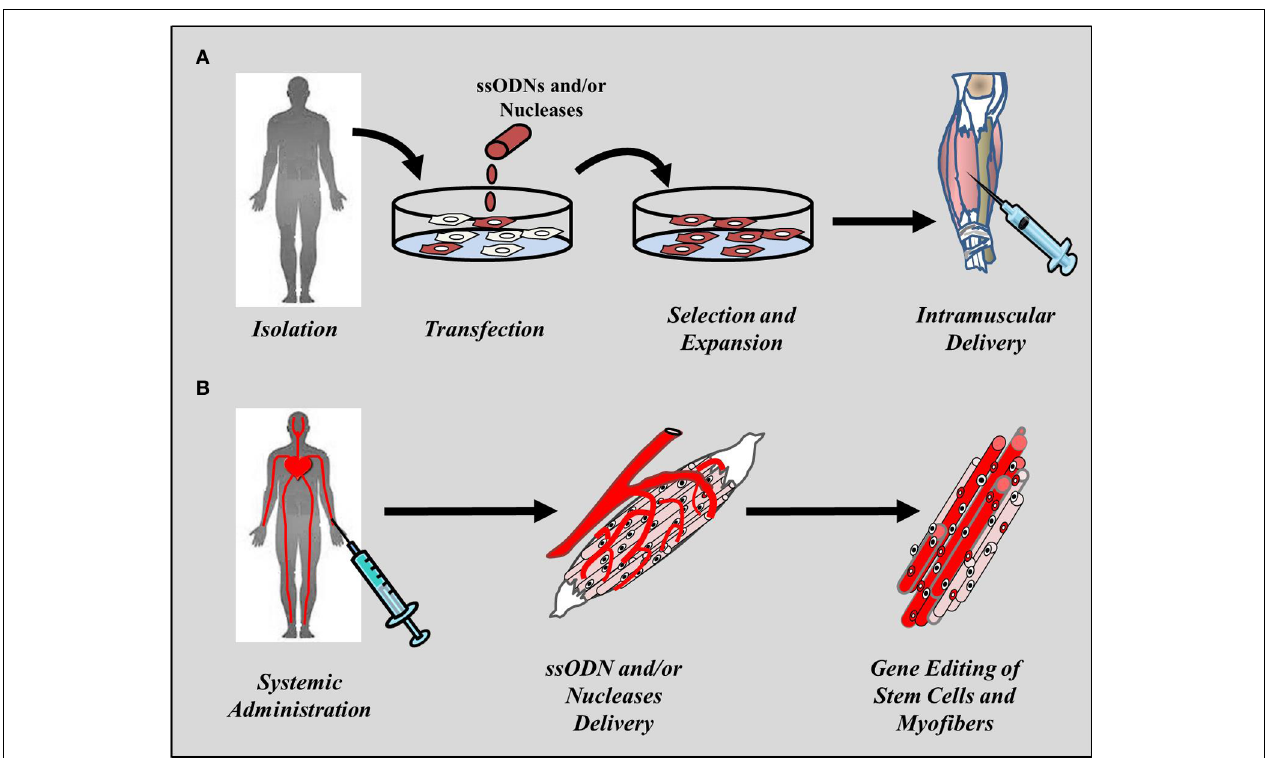
FIGURE 1 | Cell-mediated regenerative approaches to muscle disorders. Gene editing strategies in muscle stem cells are aimed at either correcting the genetic disorder ex vivo or at delivery the therapeutic agent in situ following systemic administration. (A) Ex vivo approaches requires harvesting of cells from the patient or healthy donor, reprogramming in cases were the cells being employed are not muscle-derived, editing using the targeting tools, selection of the cells undergone repair and expansion prior to delivery